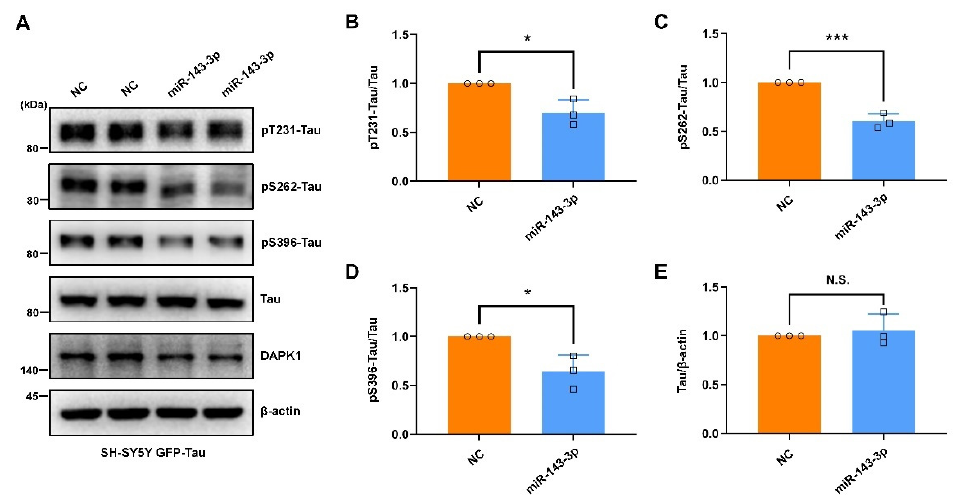
Figure 4. miR-143-3p in SH-SY5Y cells expressing exogenous GFP-tau protein inhibits tau phosphorylation. ( A ) SH-SY5Y cells expressing exogenous GFP-tau protein were transfected with miR-143-3p or NC for 48 h, and the levels of tau phosphorylated at Thr231, Ser262, and Ser396, total tau, and DAPK1 were analyzed by immunoblotting. ( B – E ) Relative quantification was determined using ImageJ software, and the results are presented as a histogram. The data (circles and squares) are presented as the mean ± SD of three independent experiments (* p < 0.05, *** p < 0.001, N.S., not significant).